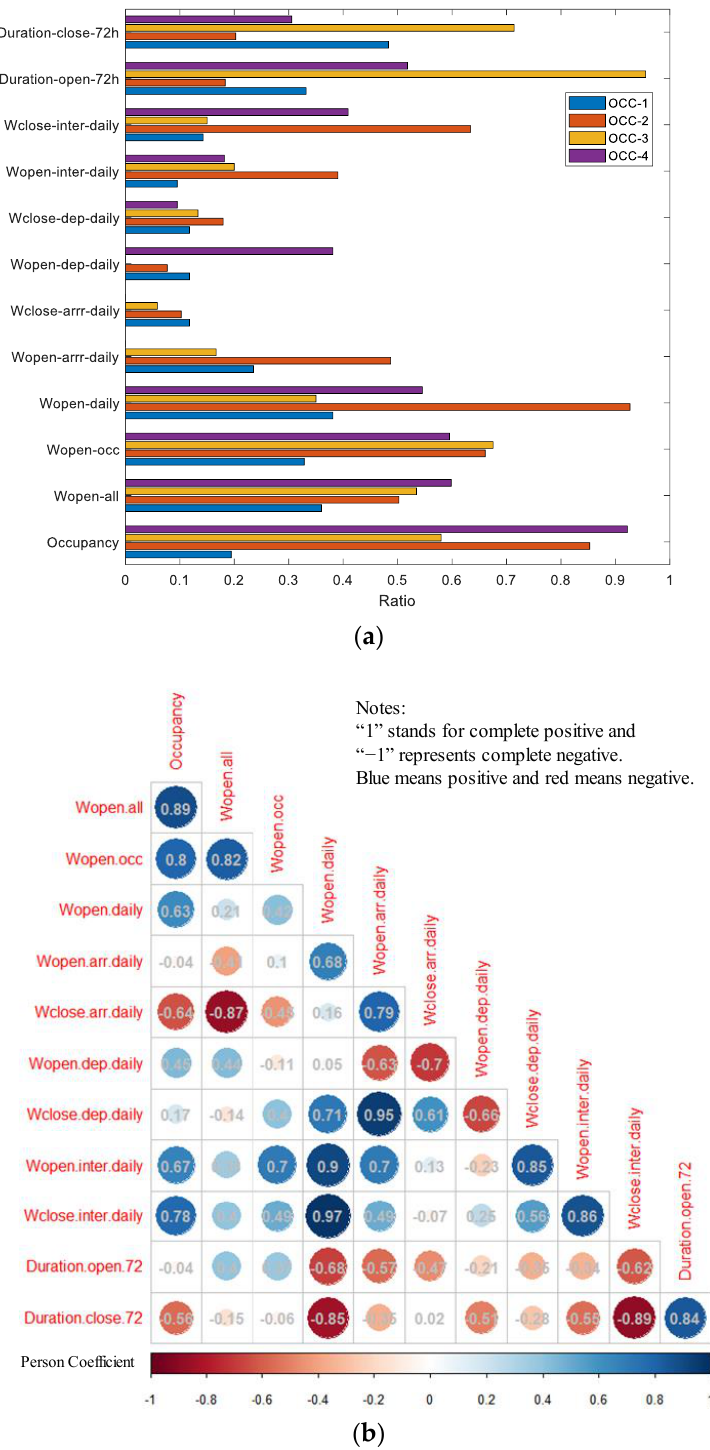
Figure 7. Analysis of behavioral characteristics. ( a ) The 12 factors for the window opening behavior. ( b ) 12 The relationship between the 12 factors.